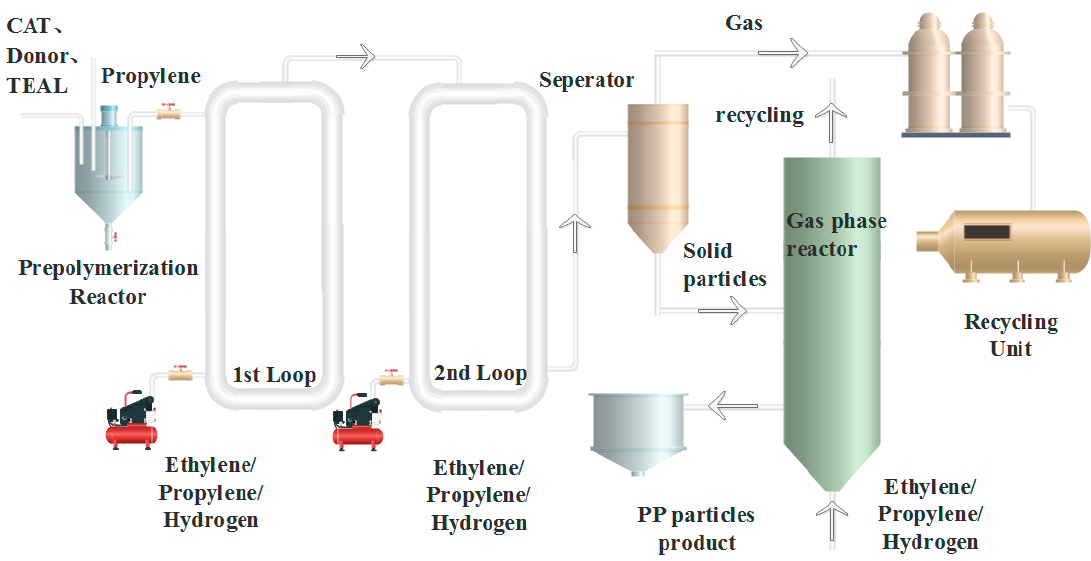
Figure 1. The schematic process of Spheripol II. CAT: Z-N catalyst, TEAL: triethylaluminum, Donor: cyclohexyl methyl dimethoxysilane.